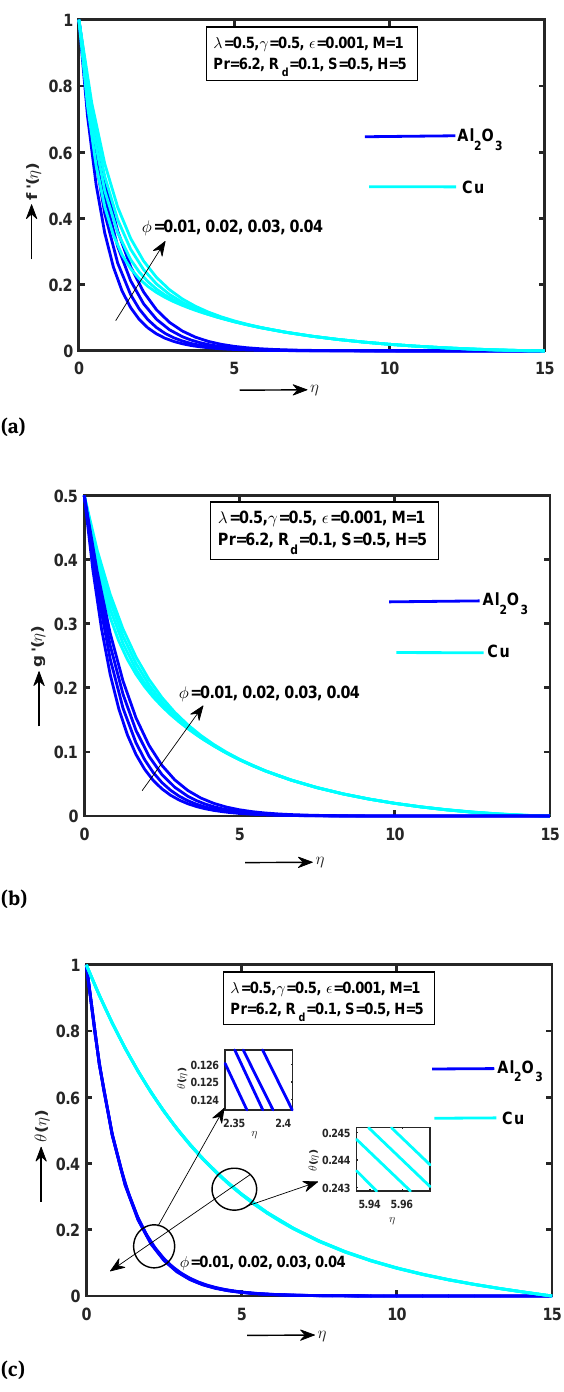
Figure 6: (a) Significance of ϕ on f (cid:48) ( η ) (b) Significance of ϕ on g (cid:48) ( η ) (c) Significance of ϕ on θ ( η